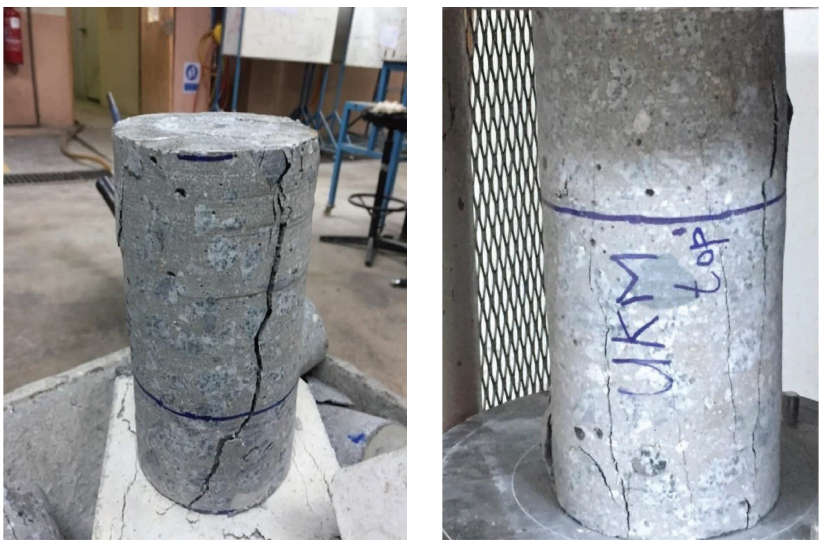
Figure 8: Failure of coring SPC and MYC sample after